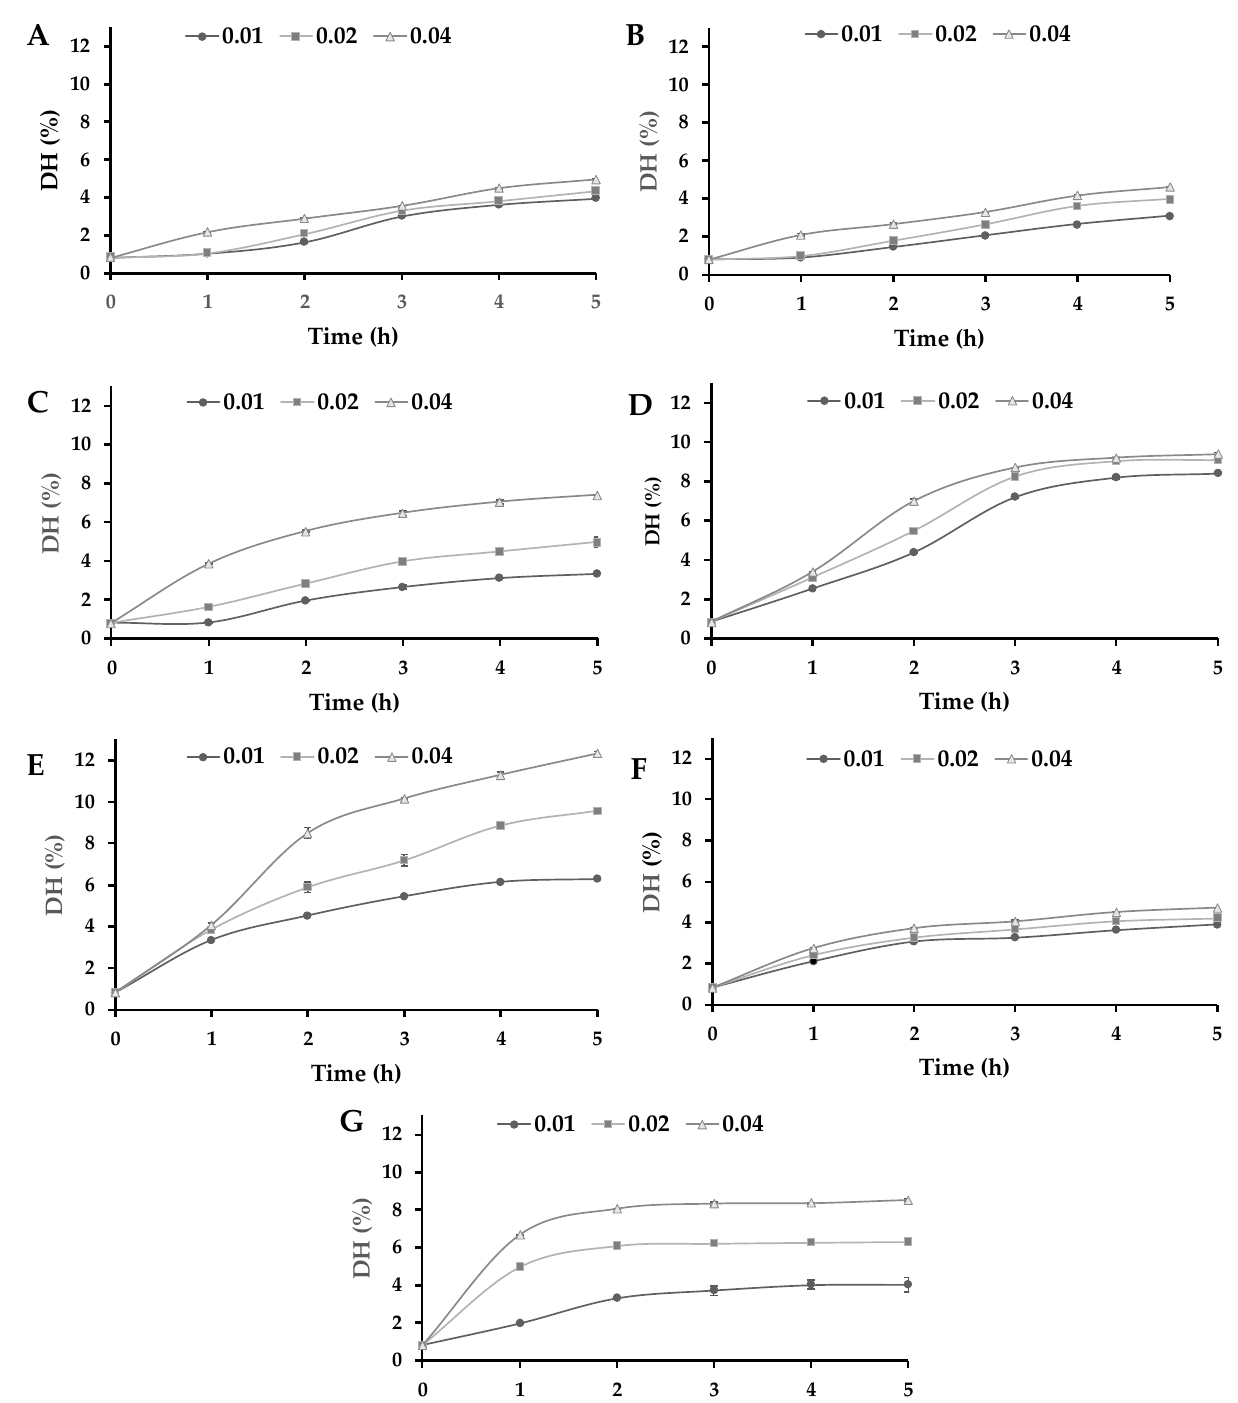
Figure 1. Degree of hydrolysis (DH) of LPI hydrolysates by different commercial enzymes. ( A ) Acid Stable Protease, ( B ) Fungal Protease A, ( C ) Opti-Ziome TM P 3 Hydrolyzer TM , ( D ) Neutral Protease, ( E ) Protamex ® , ( F ) Alcaline Protease L, and ( G ) Alcalase ® 2.4 L FG. The DH was strongly dependent on the E/S ratio in most of the enzymes except for aspartic proteases (Acid Stable Protease and Fungal Protease A) and a serine protease (Alcaline Protease L), where the increase in the E/S ratio does not have a great influence in the DH values. Among the proteases, Protamex ® , Neutral Protease, and Alcalase ® 2.4